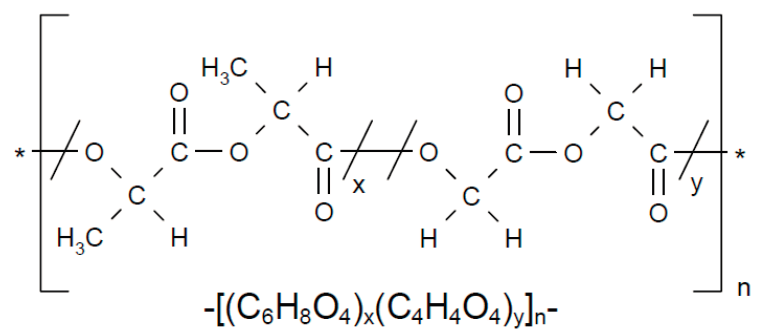
Figure 2. Chemical structured of PLGA types. Chemical structure of PLGA 50:50 (R 502H); Chemical structure of PLGA 75:25 (R